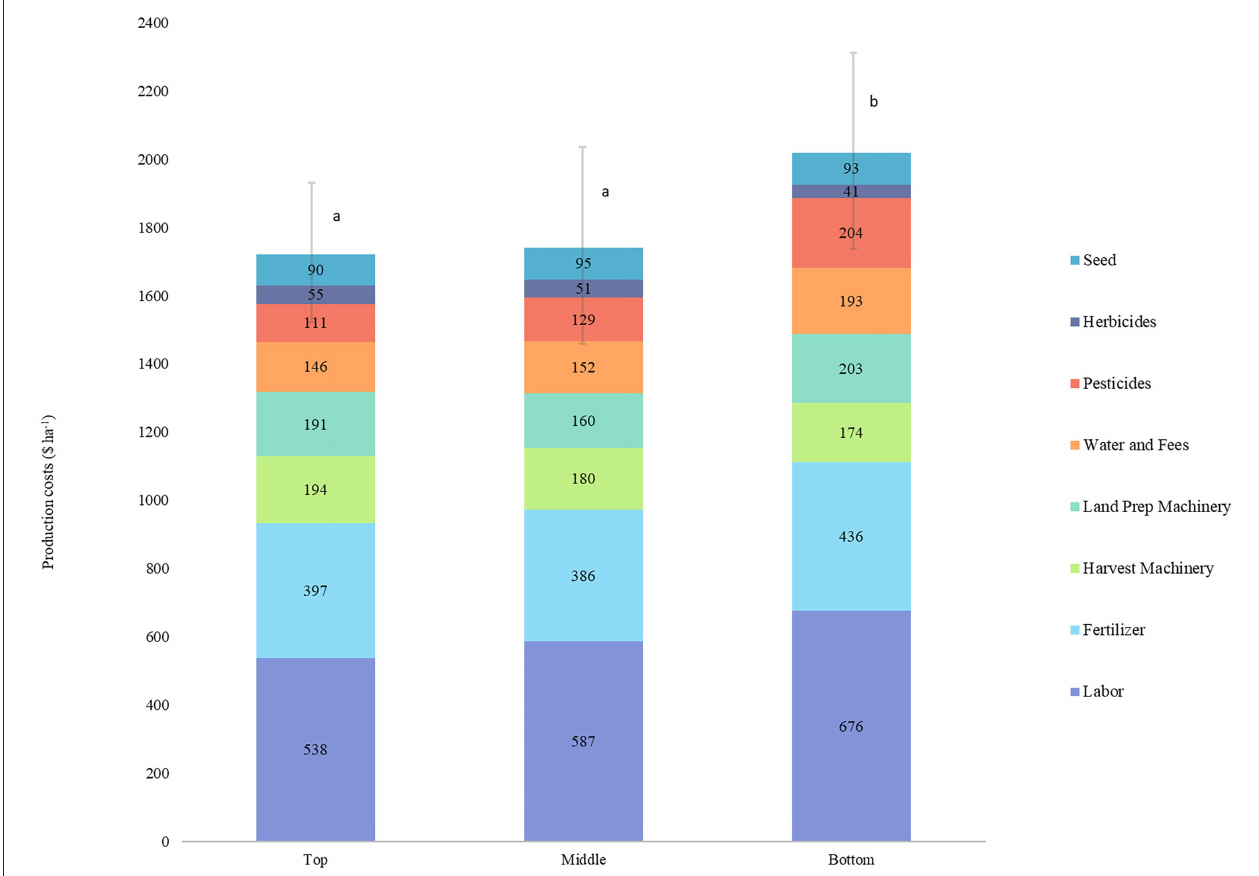
FIGURE 3 | Average production costs delineated by profit groups (top, middle, bottom) for 65 farmers in Ferreñafe, Peru. Farmers are grouped into profitability categories based on net profit: top (top 20%; n = 13), middle (middle 60%, n = 39), and bottom (bottom 20%, n =